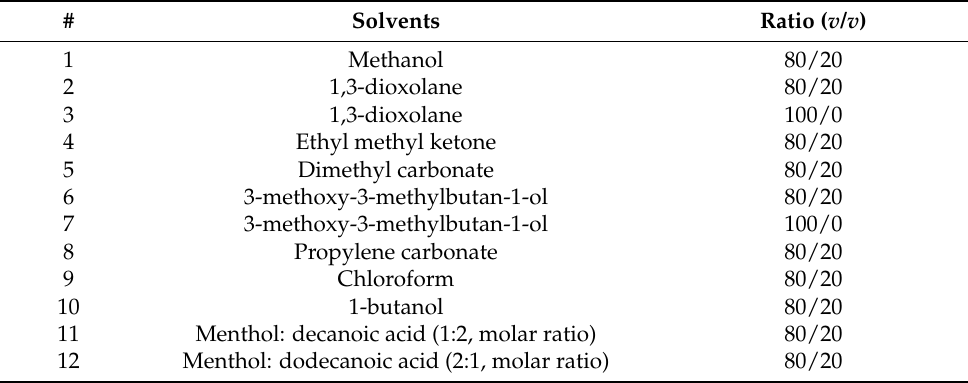
Table 1. List of solvents and solvent/water ratios